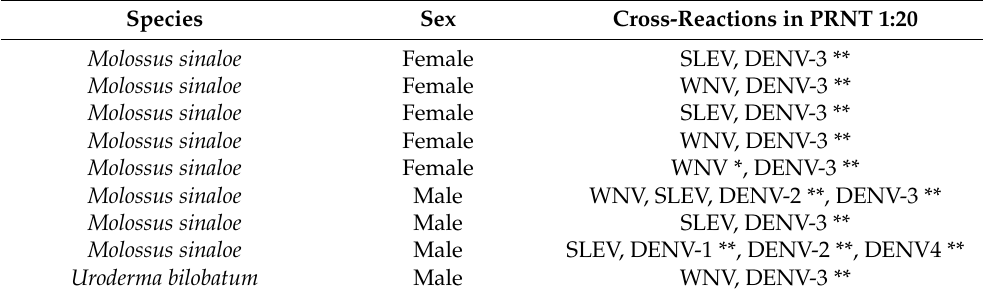
* Sample titrated and with antibodies titers against WNV > 1:640; ** data from our previous study already published